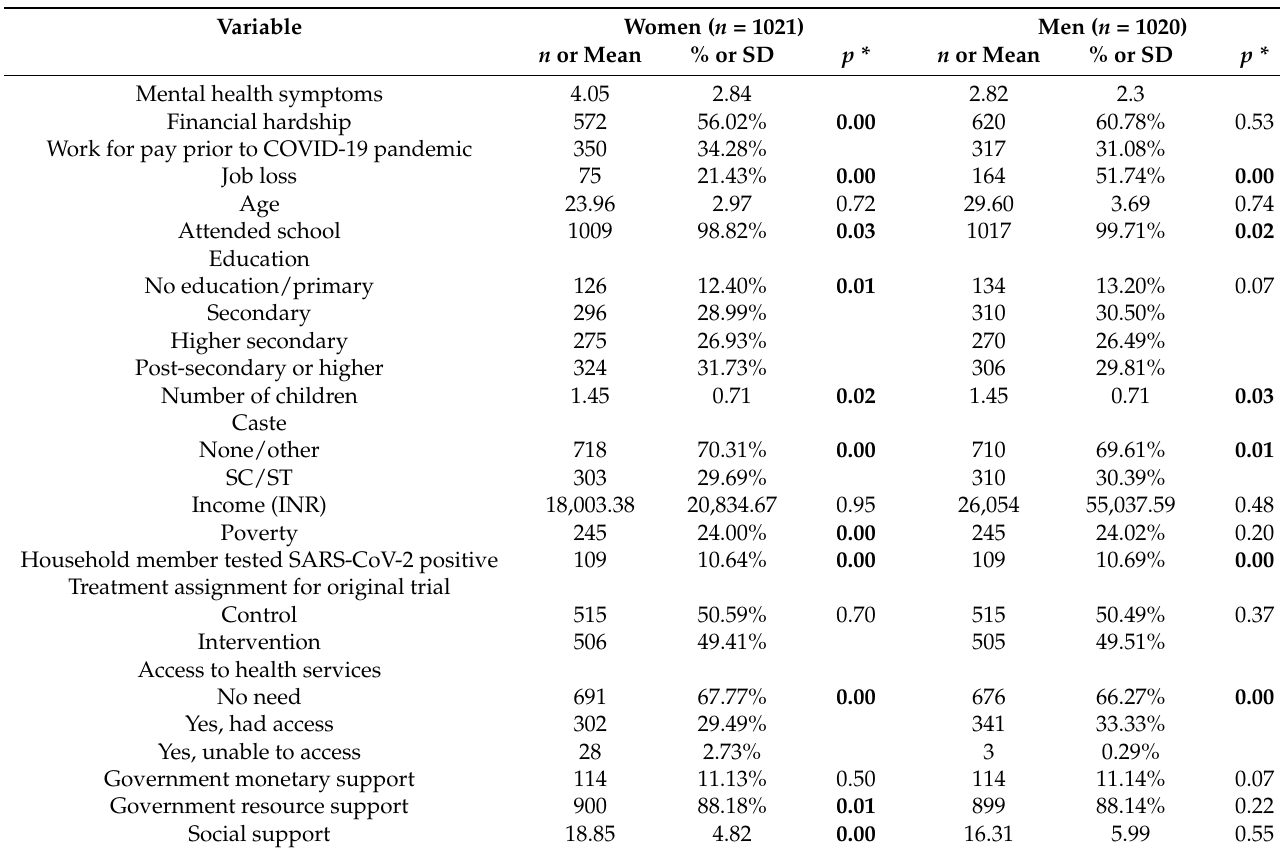
Table 1. Descriptive statistics of